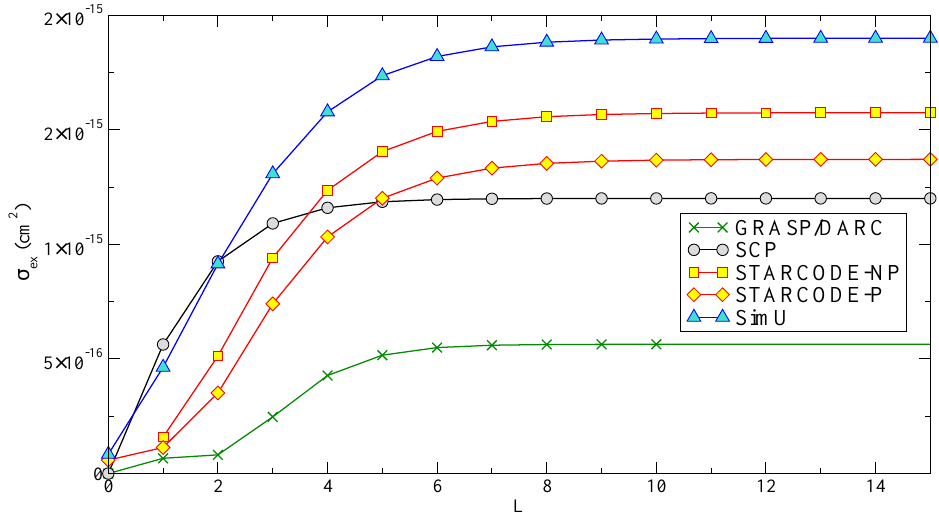
Figure 12. B III 2 s − 2 p cumulative excitation cross-section as a function of L , for an energy equal to 7eV.